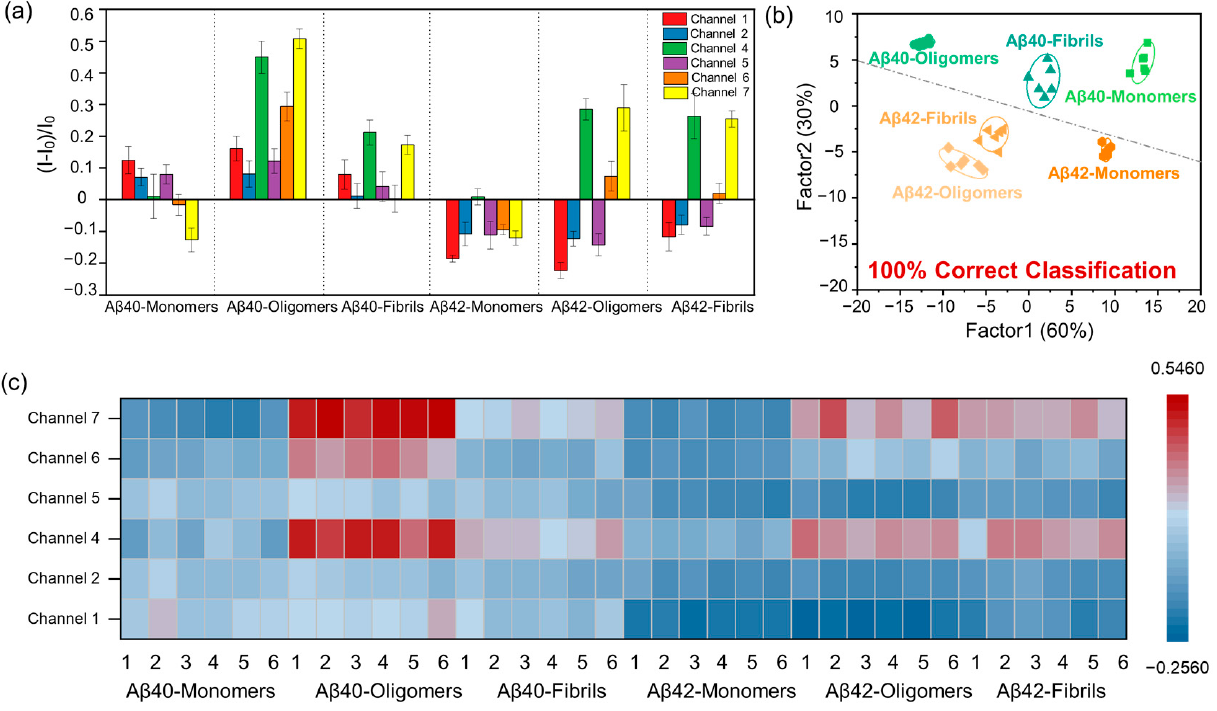
Figure 3. ( a ) Principal component analysis (PCA) contribution plots for channel 1-channel 10. ( b ) Canonical score plot for the first two factors of fluorescence patterns obtained from the optimized 6-channel sensor array with six A β 40/A β 42 species in PBS.